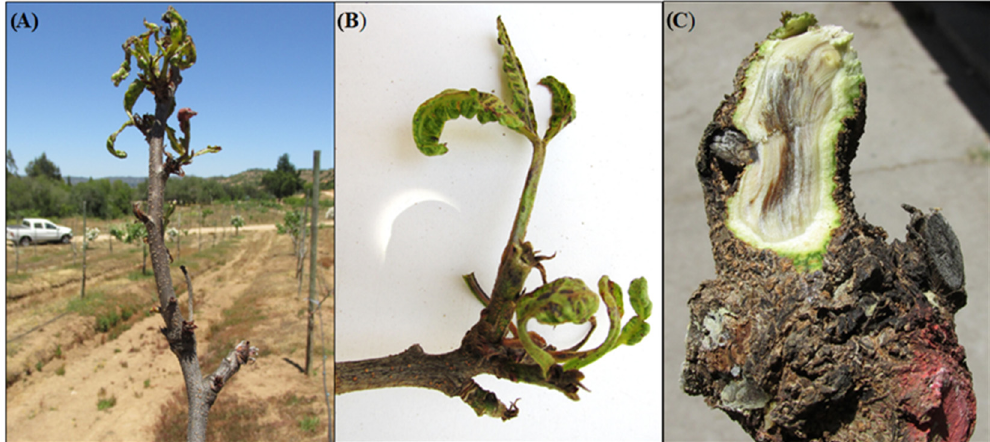
Figure 1. Symptoms of dieback and necrosis in pistachio trees: ( A ) diseased tree; ( B ) necrosis of twigs and leaves; ( C ) necrosis of the woody tissue in the trunk.